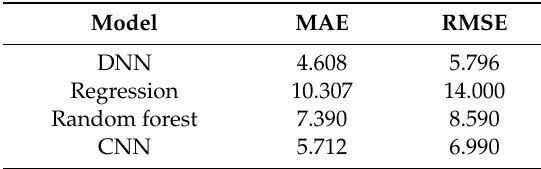
Table 5. The results for the four models using the serialization